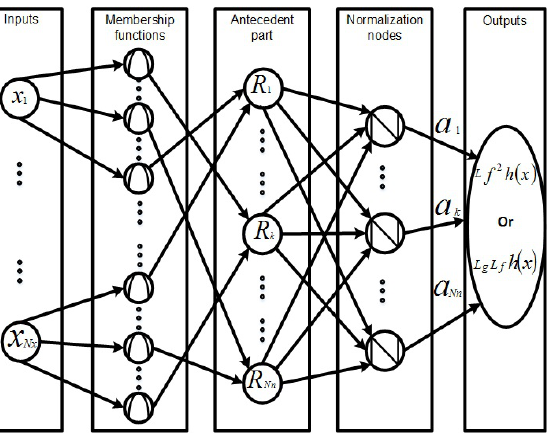
Figure 3. MISO adaptive NeuroFuzzy network structure for the estimation of L f 2 h ( x ) and L g L f h ( x )